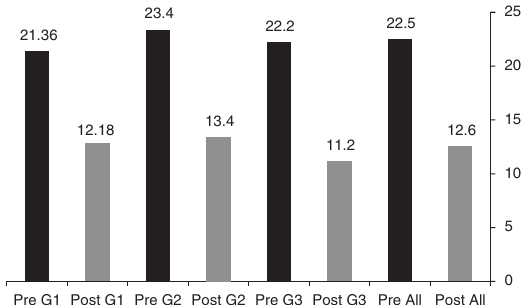
ABG mean in dBs pre and postoperatively of the three groups, and for the total number of patients. each group the ABG pre and postoperatively is shown in Fig. 2. The mean of ABG difference (Pre-Postop) was also demonstrated in Table